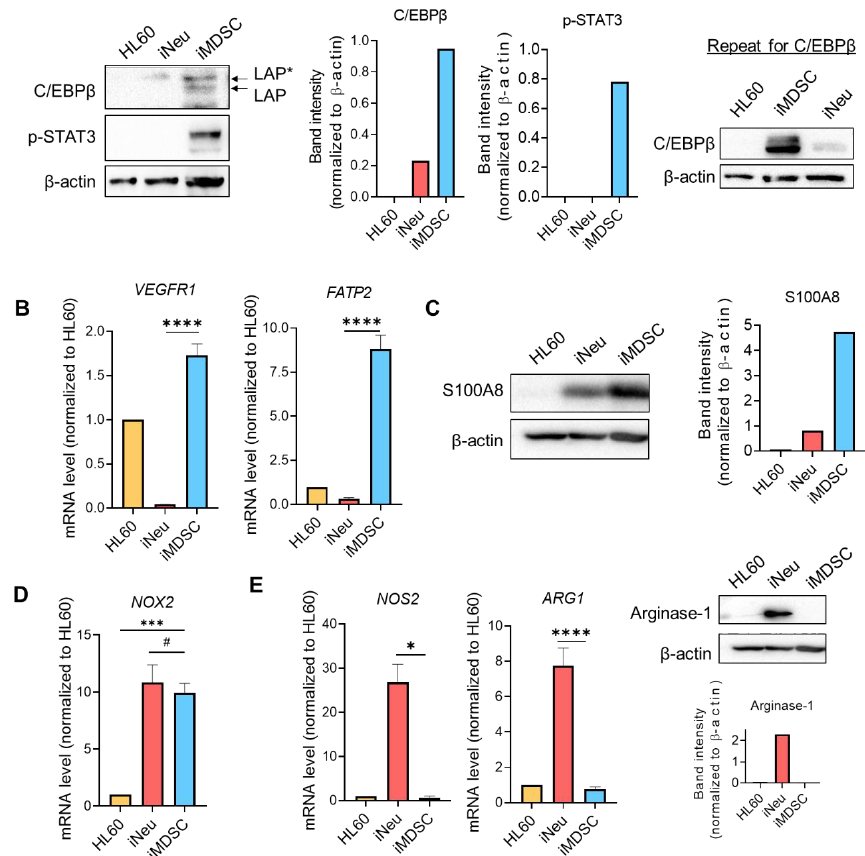
Figure 4. iMDSC selectively upregulate the expression of MDSC functional players. ( A ) Protein levels of C/EBPβ and phospho-STAT3 (Tyr705) in HL60, iNeu and iMDSC, detected by Western blot. The normalized band intensity was shown. Shown on the right is the repeat experiment for C/EBPβ with independently extracted cell lysates. (B) Expression of VEGFR1 and FATP2 (measured by qRT-PCR) in HL60, iNeu and iMDSC. Relative mRNA was normalized to GAPDH (internal control) and HL60 (the reference baseline of 1.0). (C) Protein level of S100A8 in HL60, iNeu and iMDSC, detected by Western blot. The normalized band intensity was shown. (D) Expression of NOX2 (measured by qRT- PCR) in HL60, iNeu and iMDSC. Relative mRNA was normalized to GAPDH (internal control) and HL60 (the reference baseline of 1.0). (E) Expression of NOS2 and ARG1 at the mRNA level measured by qRT-PCR, and Arginase-1 at the protein level detected by Western blot in HL60, iNeu and iMDSC. In ( B,D,E ), # p > 0.05, * p <0.05, *** p <0.001, **** p < 0.0001, two-tailed Student’s t-test. For ( D ), one-way ANOVA followed by multiple comparisons returned equivalent significance levels. Next, we examined the expression of a few previously identified genes that facilitate MDSC expansion or execute the immunosuppressive function of MDSCs. Vascular endothelial growth factor receptor 1 (VEGFR1) is upregulated in both human and mouse PMN-MDSCs and mediate VEGF- dependent MDSC expansion and infiltration to the tumor bed [21,31]. Fatty acid transport protein 2 (FATP2) is recently identified to be exclusively upregulated by both human and mouse PMN-MDSCs compared with neutrophils [32]. FATP2 is activated by the GM-CSF/STAT5 signaling axis and promotes arachidonic acid uptake to enhance MDSC immunosuppression [32]. In our cell system,